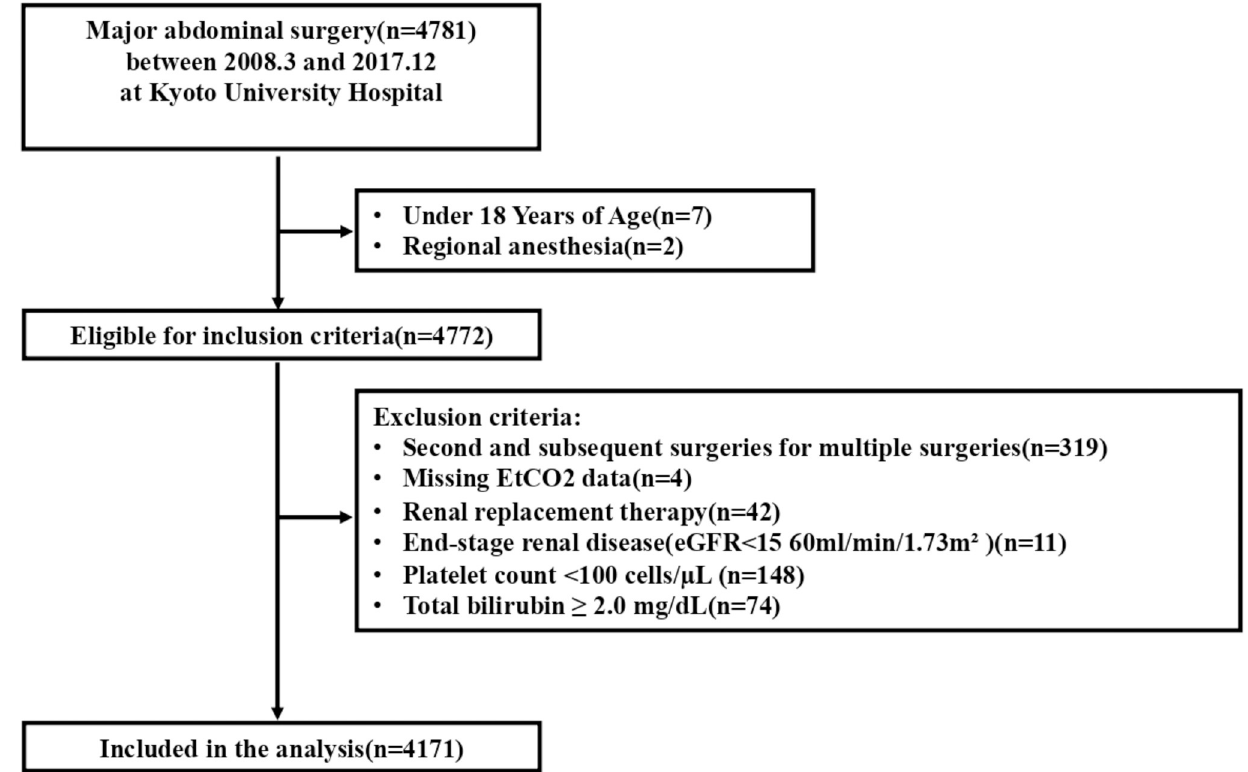
Fig 1. Flowchart of this study. We included consecutive patients aged 18 years or older who underwent major abdominal surgery under general anesthesia at Kyoto University Hospital between 2012 and 2017. Then, we extracted the cases that met our eligibility criteria and analyzed them as complete cases.